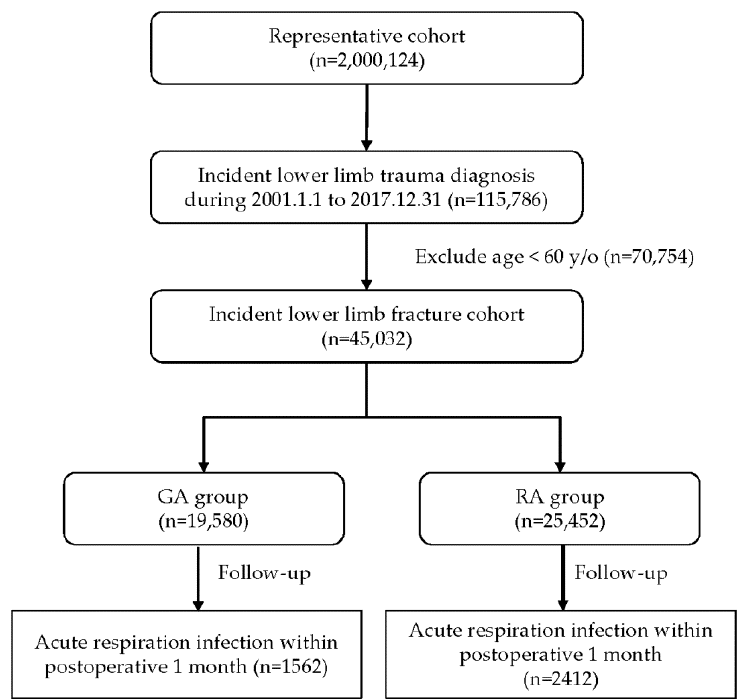
Figure 1. The flow chart of this nationwide retrospective cohort study.